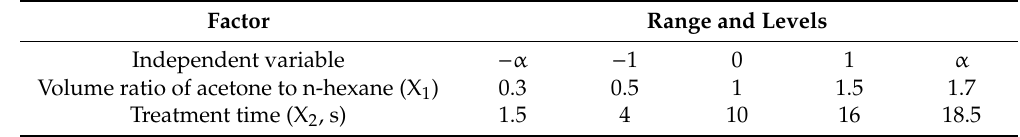
Table 2. Experimental range and levels of independent